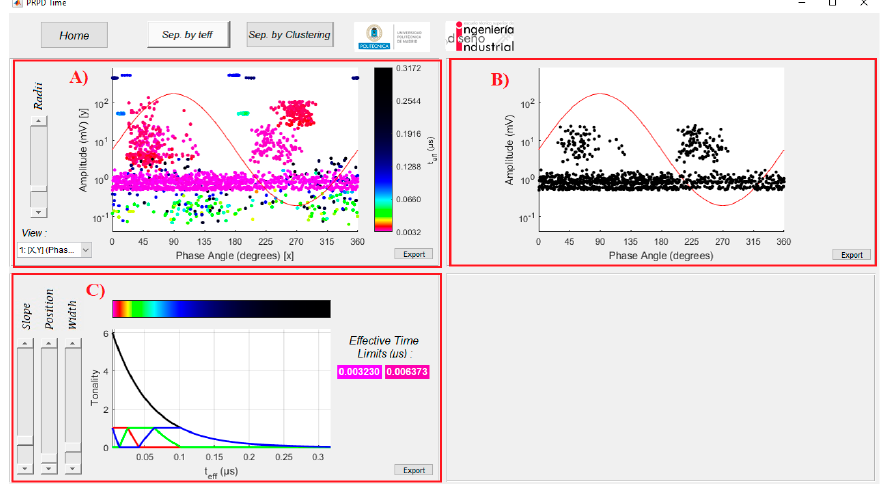
Figure 3. PD sources separation using the t eff parameter. ( A ) PRPD- t eff pattern; ( B ) classical PRPD pattern for the effective time range specified in ( C ); ( C ) controls for PD sources differentiation in PRPD- t eff patterns.